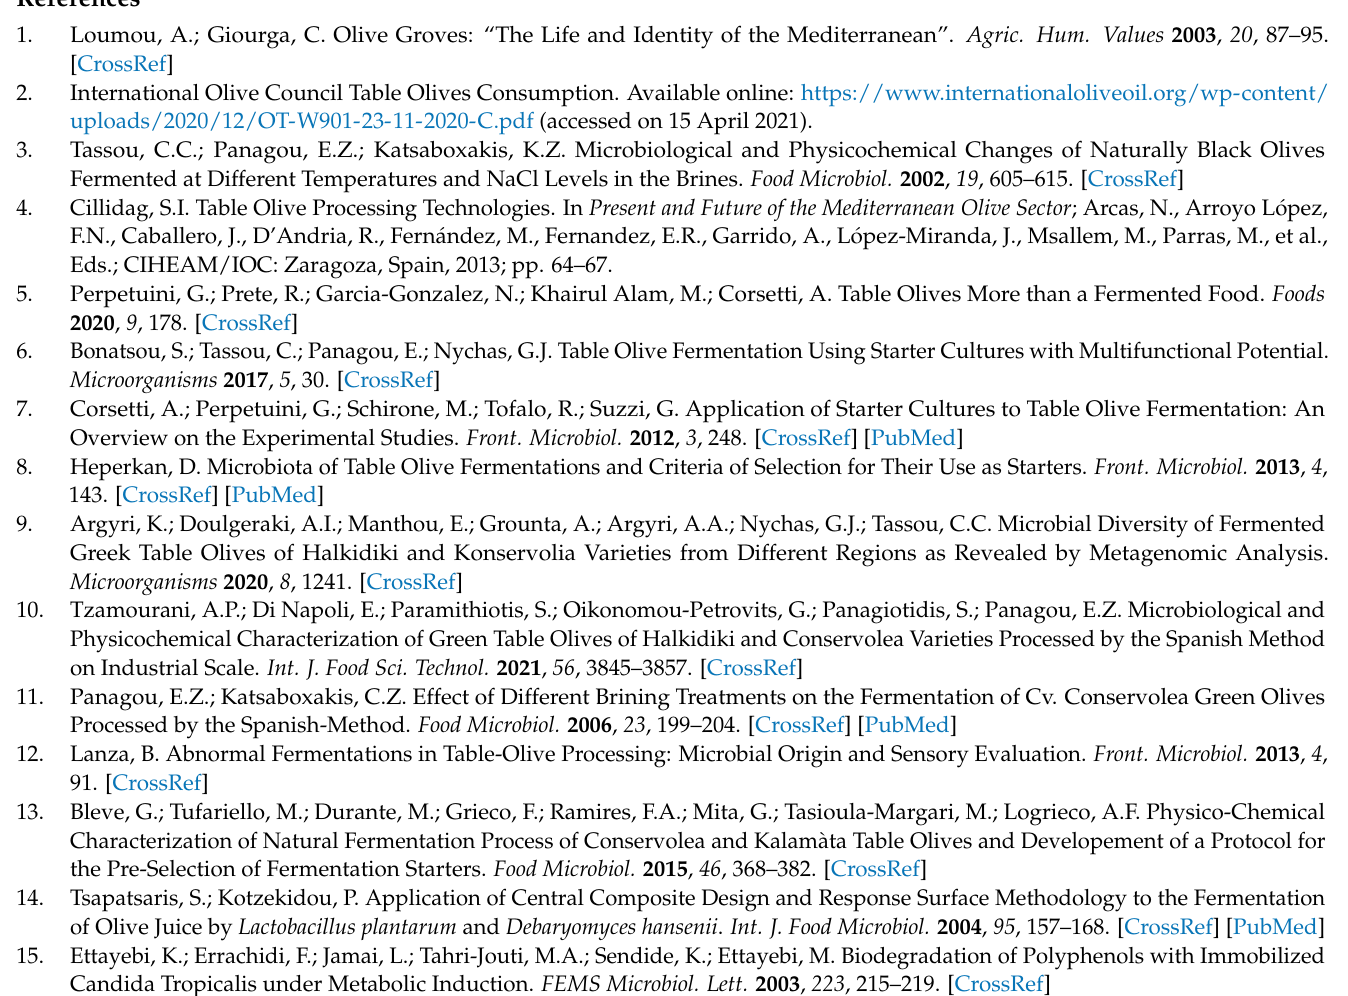
Figure S2: Principal coordinates analysis (PCoA) for the 18S rRNA amplicon metabarcoding data for all samples according to their packaging; Table S1: Number of raw and retained reads per sample after filtering for 16S and 18S rRNA sequencing results; Table S2: Table of abundances of amplicon sequence variants (ASVs) for 16S rRNA sequencing data; Table S3: Table of abundances of amplicon sequence variants (ASVs) for 18S rRNA sequencing data; Table S4: pH value of all olive samples; measurements were made in triplicates. SD, standard